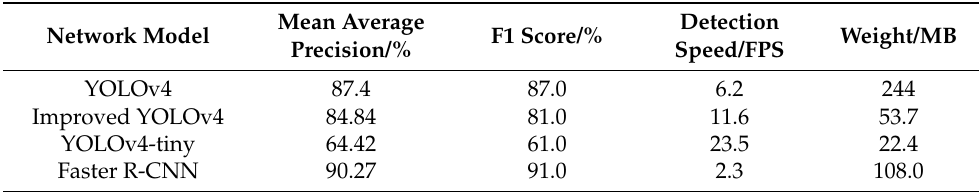
Table 2. Comparison of detection results of different models.